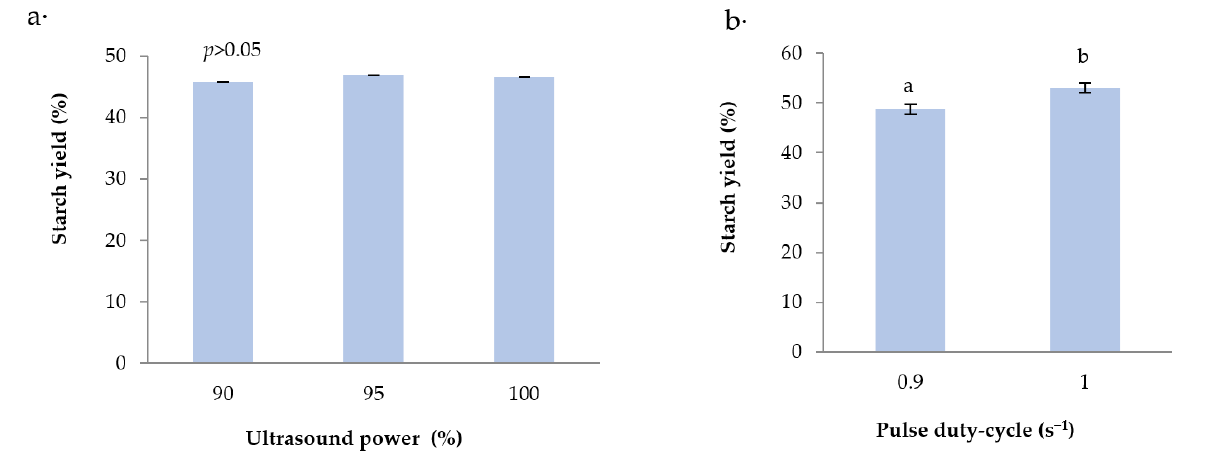
Figure 4. Further optimization: ( a ) effect of ultrasound power and ( b ) effect of pulse duty-cycle on the starch yield (%). Note: Bars with different description letters indicate a significant difference ( p < 0.05).